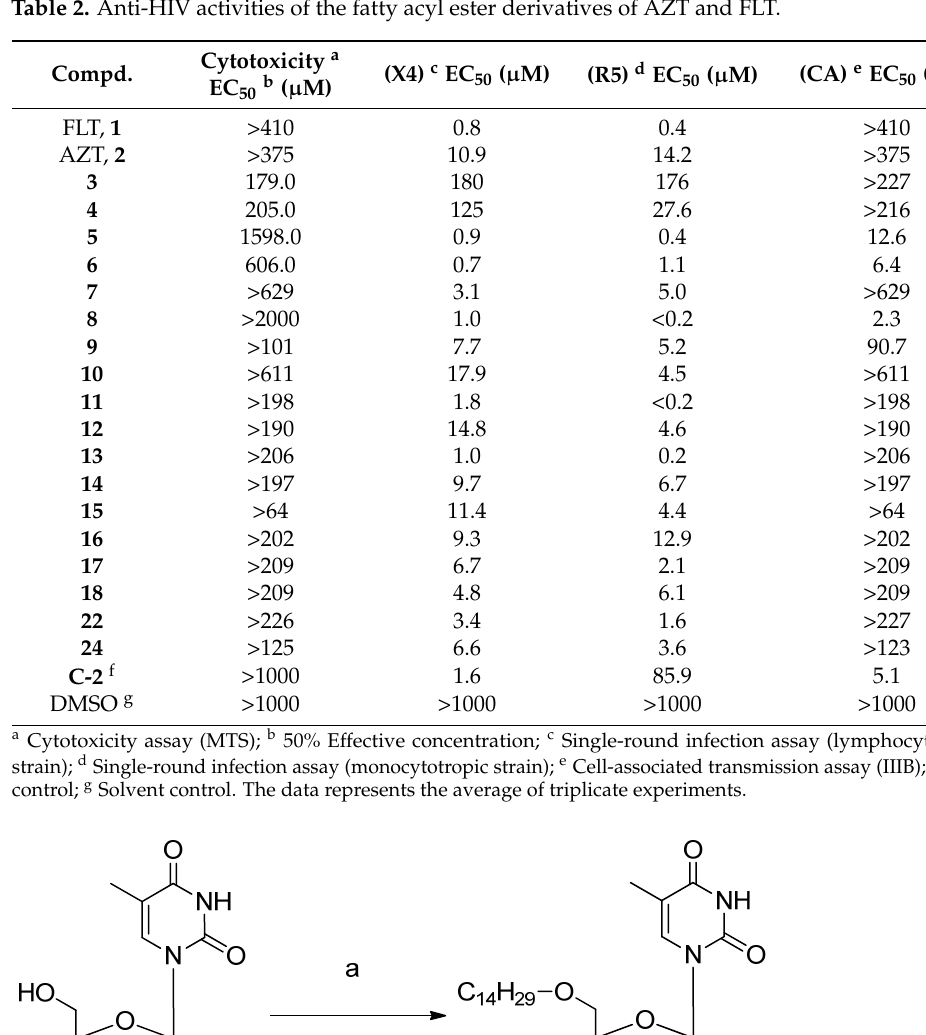
Table 2. Anti-HIV activities of the fatty acyl ester derivatives of AZT and